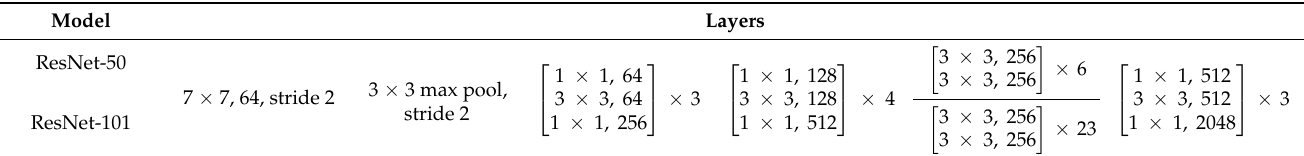
Table 2. ResNet-50 and ResNet-101 architecture.